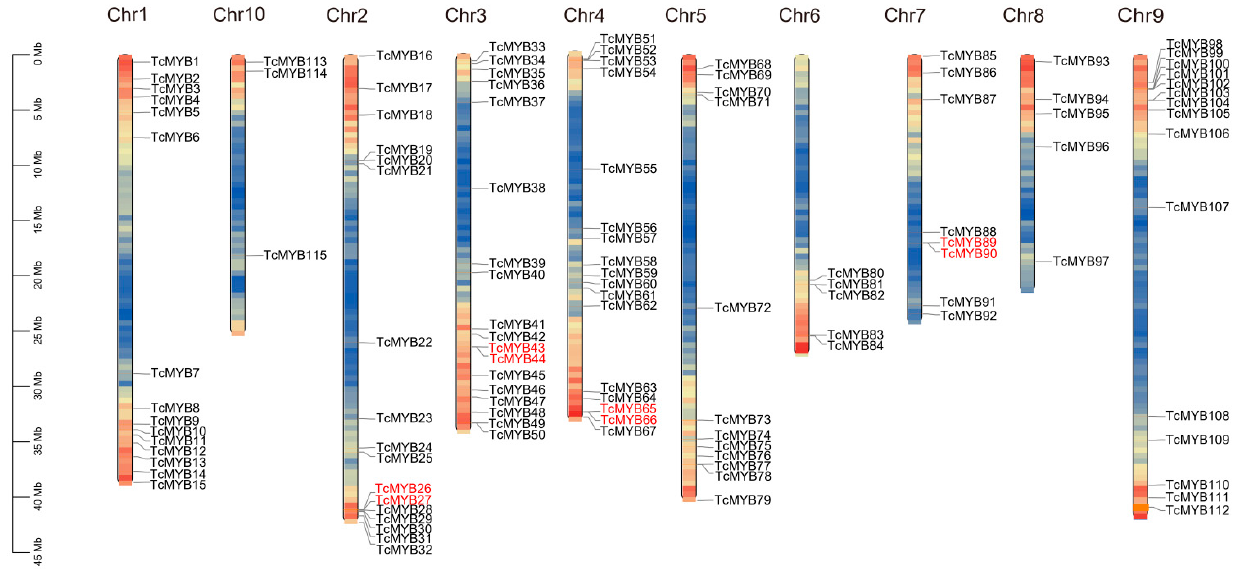
Figure 3. Distribution of Theobroma cacao R2R3-MYB ( TcMYB ) genes among 10 chromosomes. A total of 115 TcMYB genes were mapped to ten chromosomes. The tandem-duplicated pairs are indicated by the red color. Chromosomes are filled with gene density.